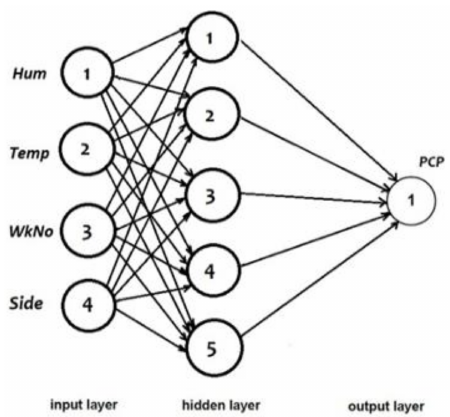
Figure 4. Network’s architecture (one input layer with four neurons, one hidden layer with five neurons, and one output layer with one